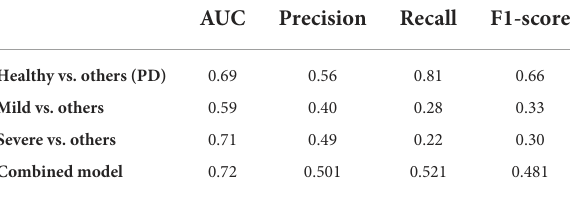
TABLE 5 Prediction performance of the